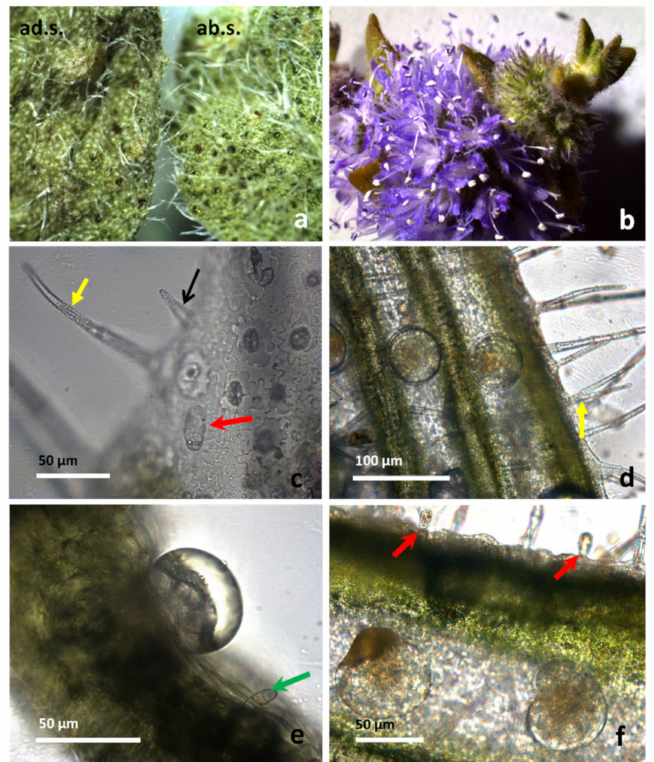
Figure 2. M. pulegium leaves ( a , c and e ) and flowers ( b , d and f ). ( a ) Comparison between adaxial (ad.s.) and abaxial (ab.s.) surfaces of mature leaves, showing a higher density of peltate trichomes on the abaxial side. ( b ) Inflorescence. Different kinds of trichomes are visible on the leaf ( c , e ) and on the calyx ( d , f ). ( c ) A short unicellular trichome is indicated by black arrows, a long multicellular uniseriate trichome by a yellow arrow, and a capitate type I trichome by a red arrow. ( d ) On the flower calyx, many peltate trichomes are scattered between the ribs, while many long, non-glandular trichomes are also visible (yellow arrow). ( e ) Transversal section of a leaf with a peltate trichome showing a large subcuticular space filled with EO, and a capitate type II trichome (green